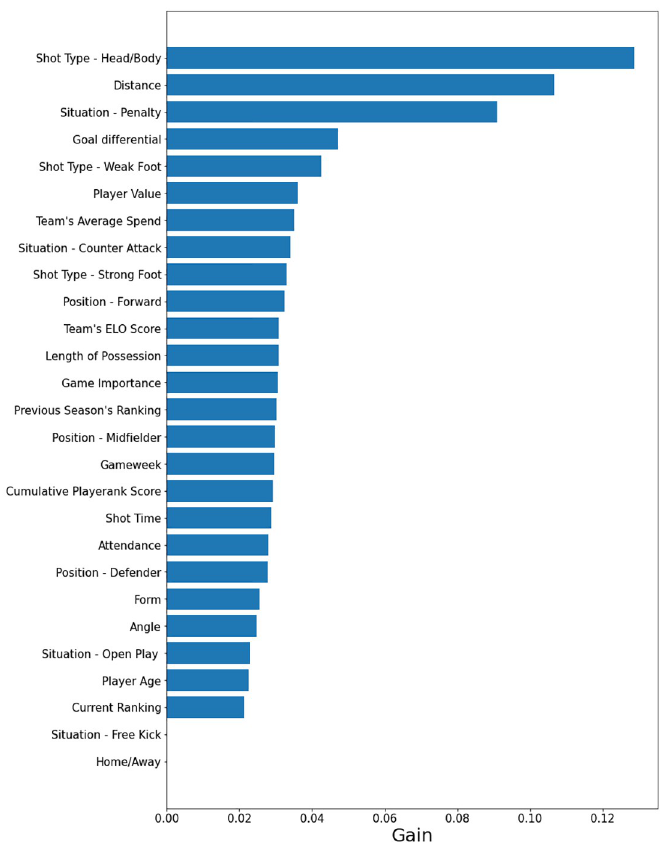
Fig 9. Important features for the German Bundesliga using the optimal model (in this case a tuned XGBoost model). We order the features in terms of Gain, the improvement in predictability attained by the variable from splitting the